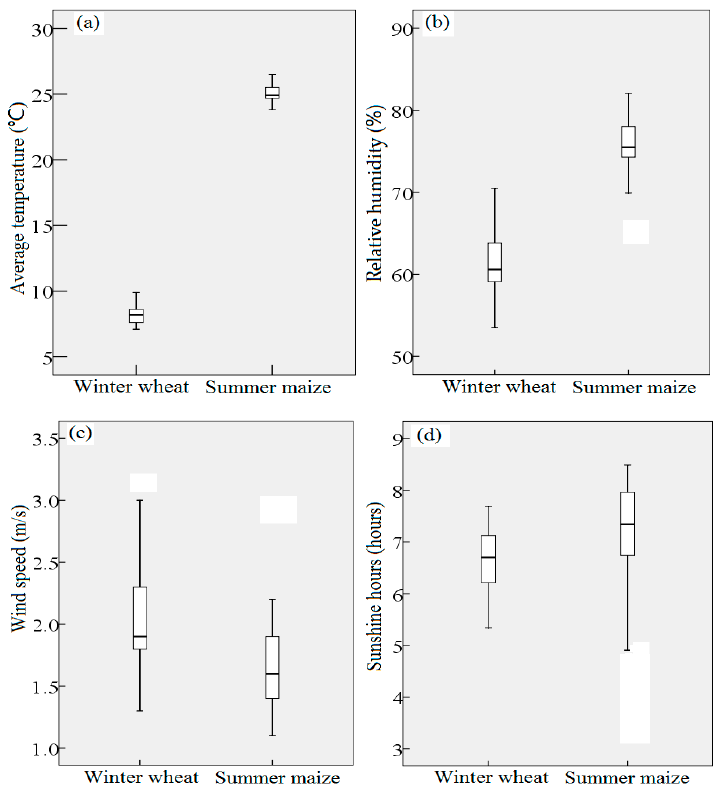
Figure 11. Variation in meteorological variables over the study period. ( a ) Average temperature; ( b ) relative humidity; ( c ) wind speed; and ( d ) sunshine hours. Table 9. Coefficients of correlations between ET 0 and meteorological variables during different seasons from 1969 to